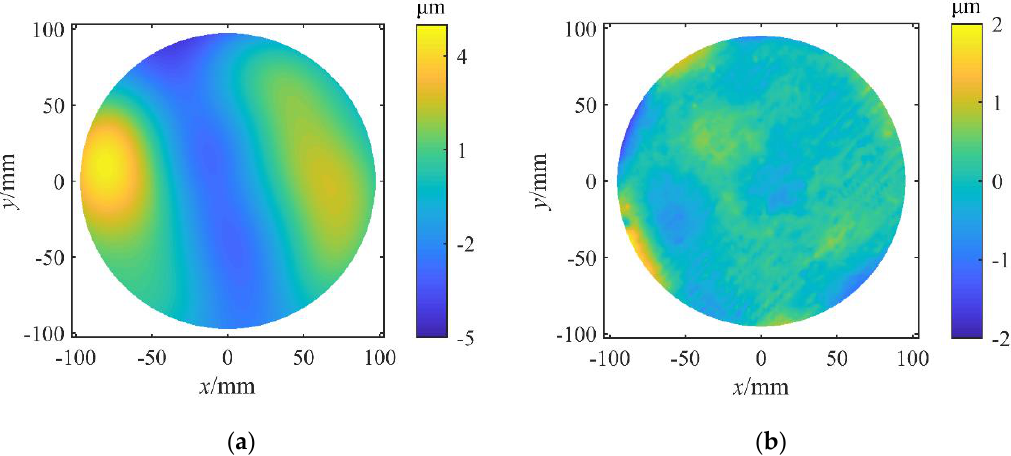
Figure 14. Simulated wafer deformation using Tikhonov regularization method under continuity constraints ( a ) and the difference from measured deformation ( b ).